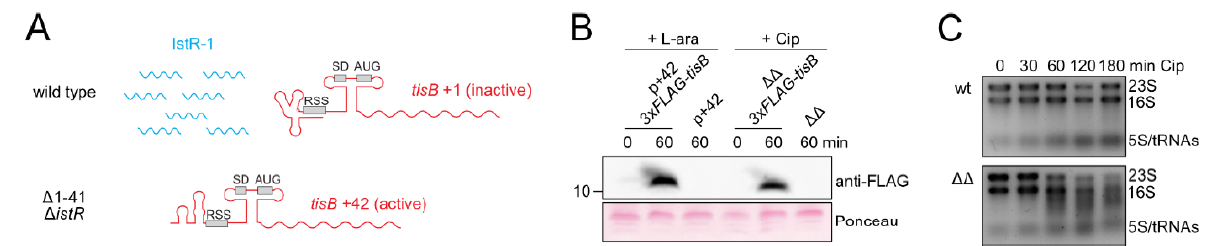
Figure 2. TisB overexpression in mutant ∆ 1-41 ∆ istR . ( A ) Graphical illustration of RNA species expressed from the tisB/istR-1 system. In the wild type, RNA antitoxin IstR-1 and the translationally inactive tisB +1 mRNA are present. In mutant ∆∆ , transcription from the LexA-dependent promoter produces the translationally active tisB +42 mRNA. ( B ) Western blot analysis of 3 × FLAG-TisB, either expressed from plasmid p+42- 3 × FLAG-tisB by addition of L-ara (0.2%), or from the ∆∆ - 3 × FLAG-tisB locus by addition of Cip (0.1 µ g mL − 1 ; 10 × MIC) for 60 min. Total protein was separated by Tricine- SDS-PAGE. 3 × FLAG-TisB was detected using an anti-FLAG antibody. Constructs without 3 × FLAG sequence served as specificity controls. Western membranes were stained with Ponceau as a loading control. ( C ) Total RNA was isolated during exponential phase (OD 600 of ~0.4) and at different time points during Cip treatment (0.1 µ g mL − 1 ; 10 × MIC). RNA quality was analyzed on agarose gels. rRNAs (23S, 16S, and 5S) and tRNAs are indicated. (wt: wild type MG1655; ∆∆ : ∆ 1-41 ∆ istR